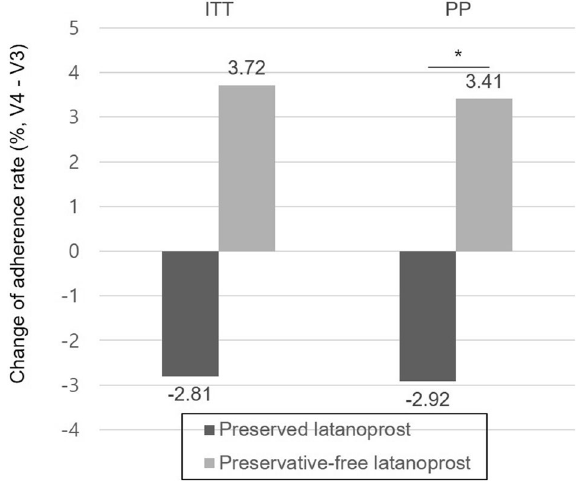
Figure 2. Comparison of adherence change between preserved and preservative-free latanoprost groups. (* represents statistical significance by paired t-test). ITT, intention-to-treat; PP,